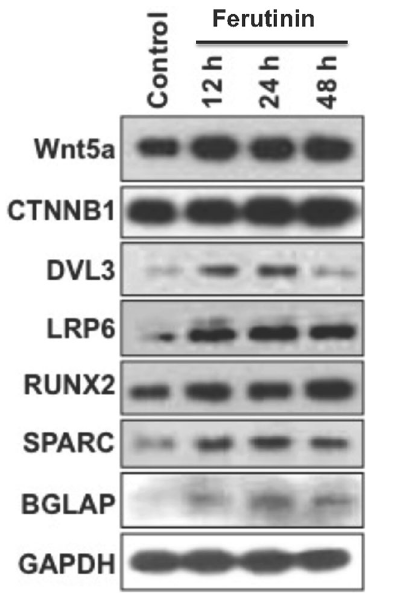
harvested at various time points as stated, whereas, vehicle-treated DPSCs were considered as a control. Western blot images are shown for various osteoblast marker proteins, and the GAPDH was considered as an internal loading control ( n =